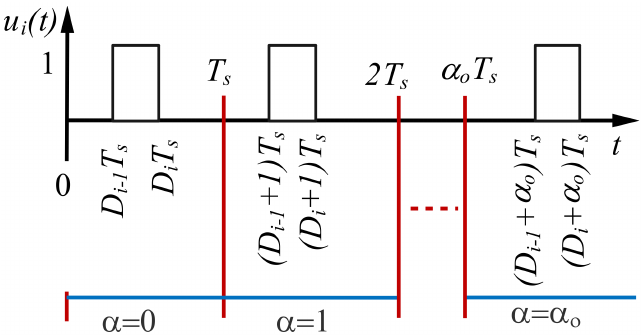
Figure 1. Graphical representation of periodic pulse u i ( t )